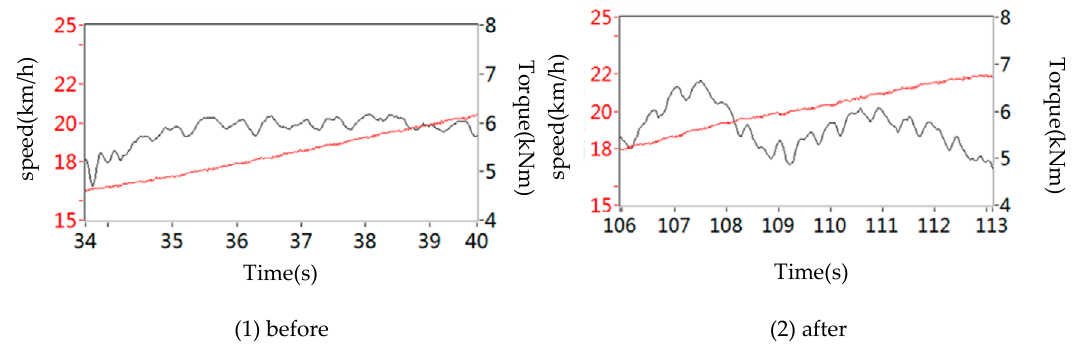
Figure 28. Comparison of results before and after correction. Table 1. Comparison of results before and after correction.